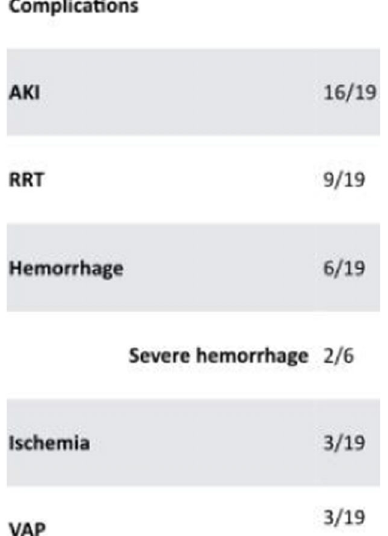
Table 3 (abstract 000914). Complications during ECMO